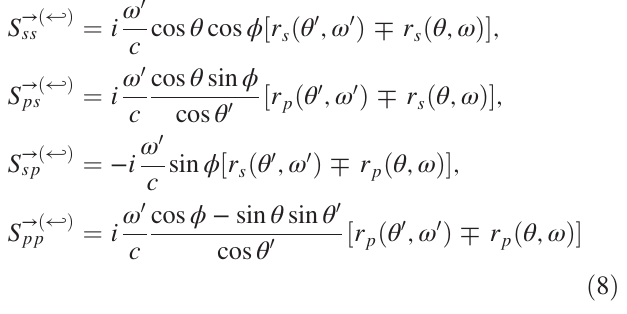
ð ω ; θ Þ ¼ ð p Þ